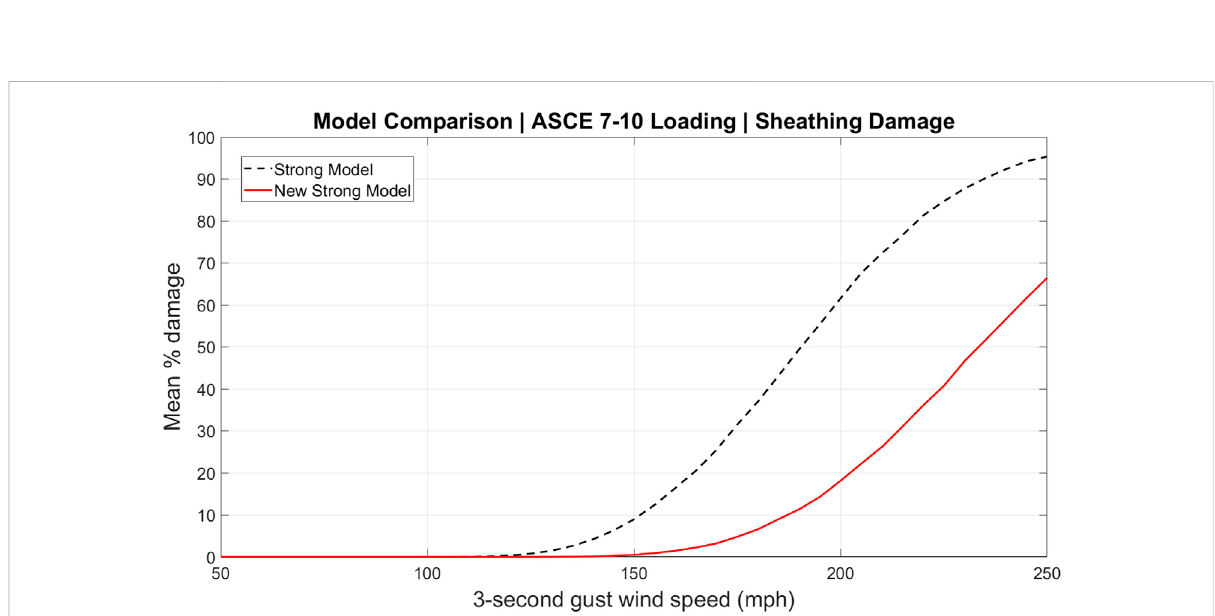
FIGURE 9 Vulnerability curves for roof sheathing damage of the strong and new strong models under ASCE 7 – 10